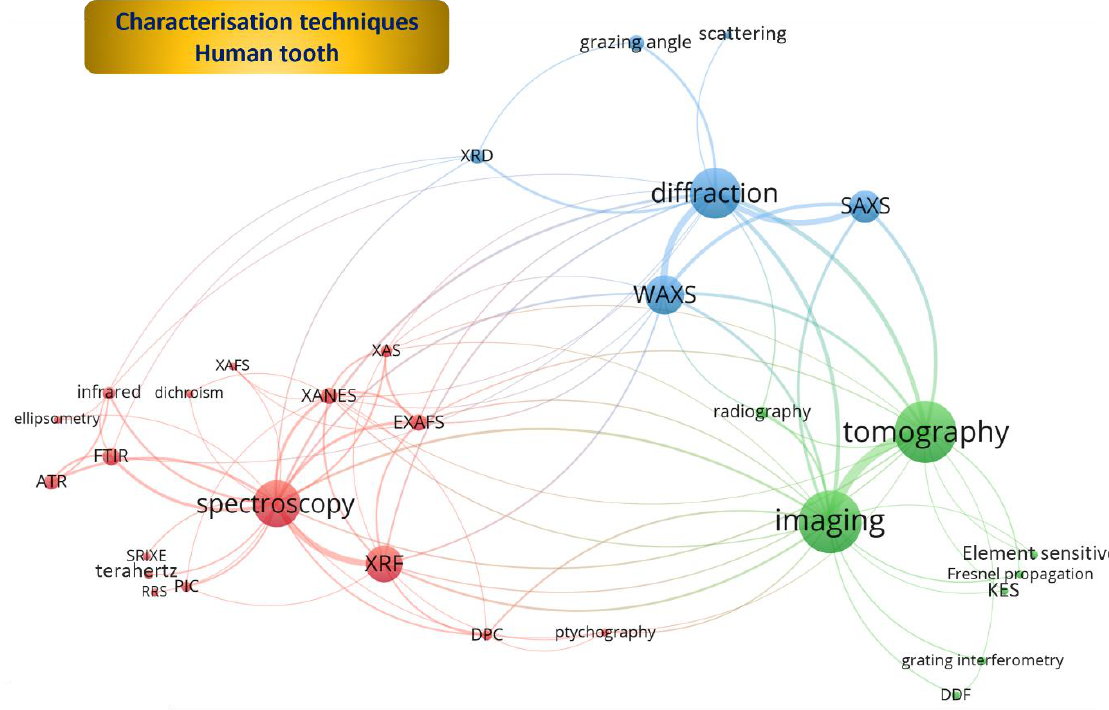
Figure 3. Visualising networks of synchrotron-based techniques used for research on human dental tissues (see also in Figure 4). A bibliometric networks map was created from the cited studies from a period of 39 years (1984 – 2023). The map was created based on text data and term co-occurrence with the software VOSviewer version 1.6.19 [284]. The data were extracted from Endnote software in ‘.txt’ format and manually edited to arrange the studies by techniques. In total , 31 terms were considered based on these studies [11,31,39,56,57,77,78,89,90,121,169 – 173,175,193,195,247,266,286,294,299,303 – 565]. This combined most of the studies we could find (to the best of our knowledge) on human teeth analysed with synchrotron radiation, along with a few on archaeological samples, e.g., Hominin and Homo juvenile. The acronyms are detailed in the man- uscript.